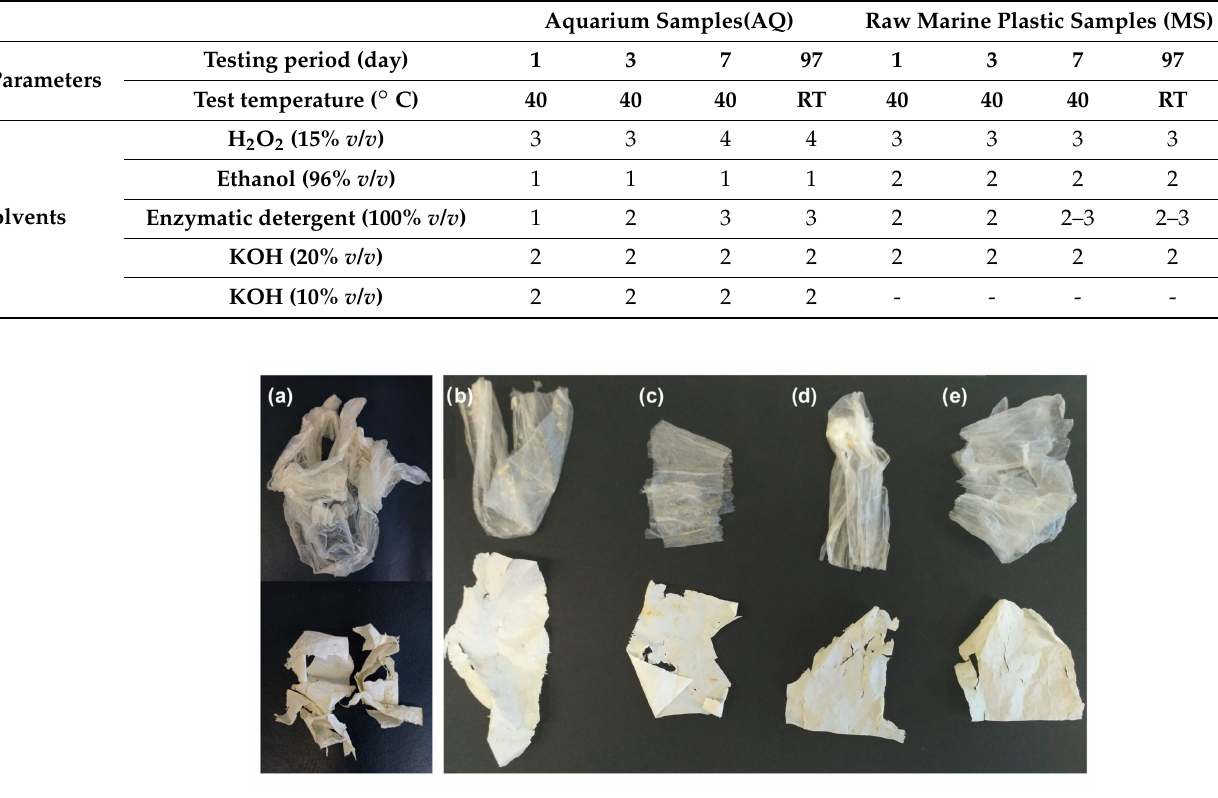
Figure 2. Initial MS samples (upper line corresponding to transparent LDPE sample, and lower line corresponding to white colored LDPE sample) ( a ) and MS samples tested with different solvents after one week: enzymatic detergent at 100% ( b ), H 2 O 2 at 15% ( c ), KOH at 20% ( d ) and ethanol at 96% ( e ). After tests, samples were cleaned with distilled water, ethanol and a tissue